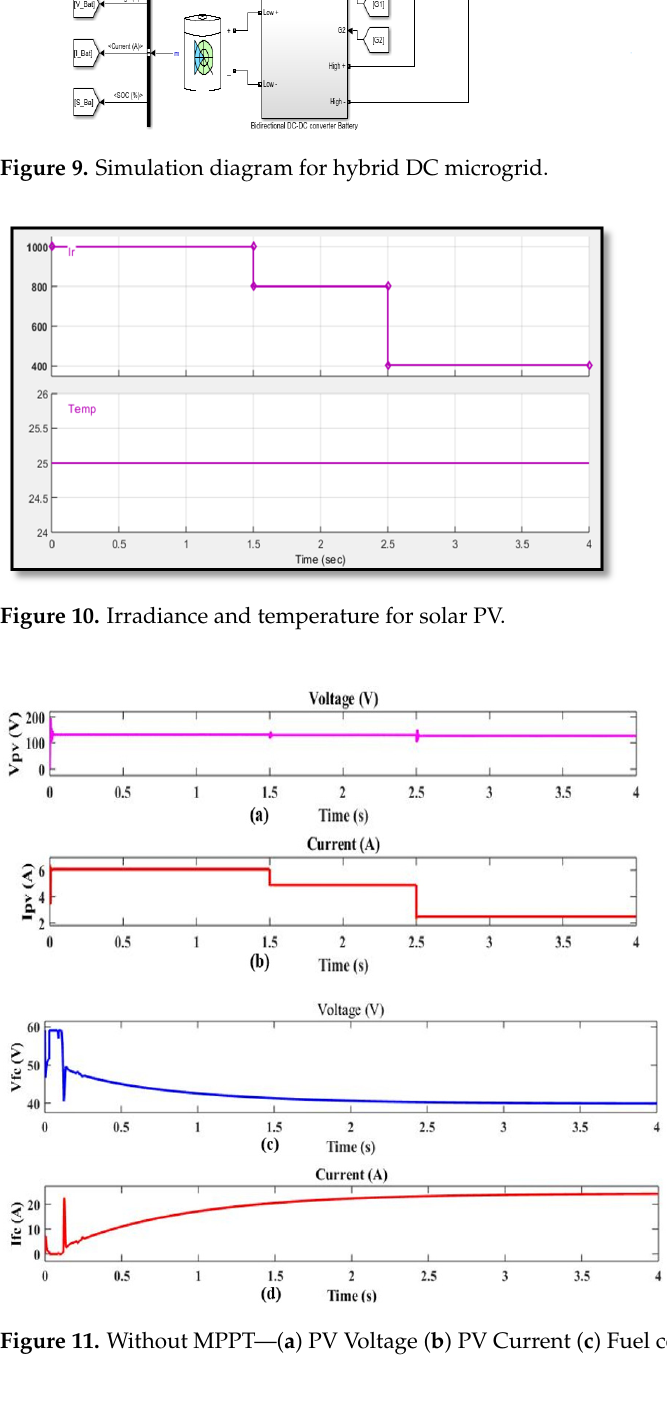
Figure 12. MPPT with triangular MF—( a ) PV voltage ( b ) PV current ( c ) Fuel cell current ( d ) Fuel cell voltage.